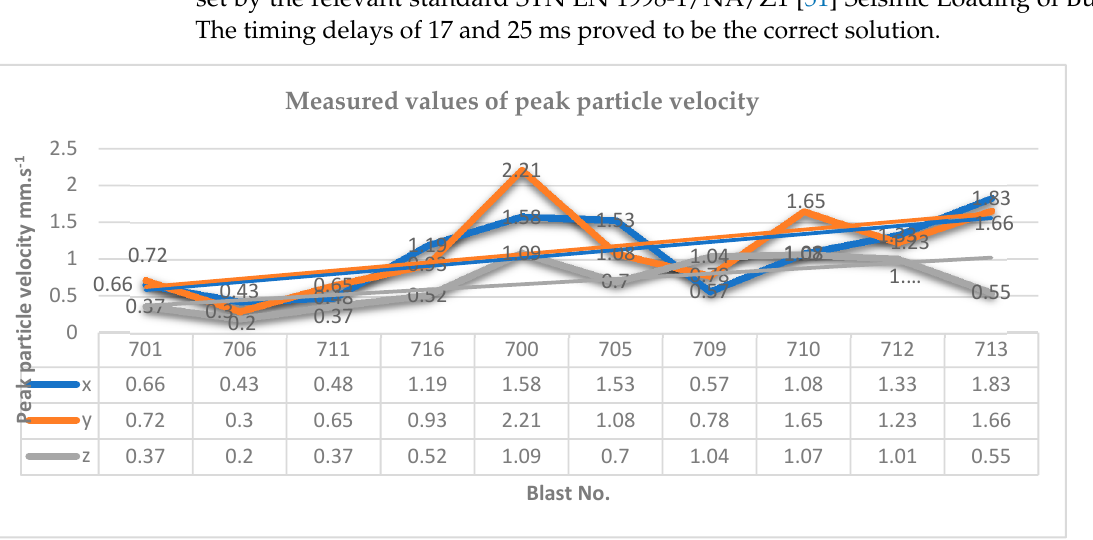
Figure 10. Dependence of measured values of peak particle velocity (source: author).